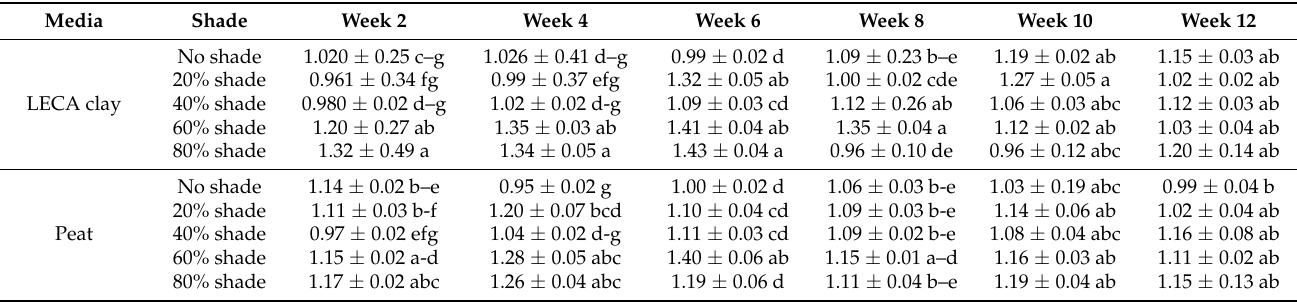
Table 2. Effect of different growth media and different shade levels on the chlorophyll content of T. divaricata.